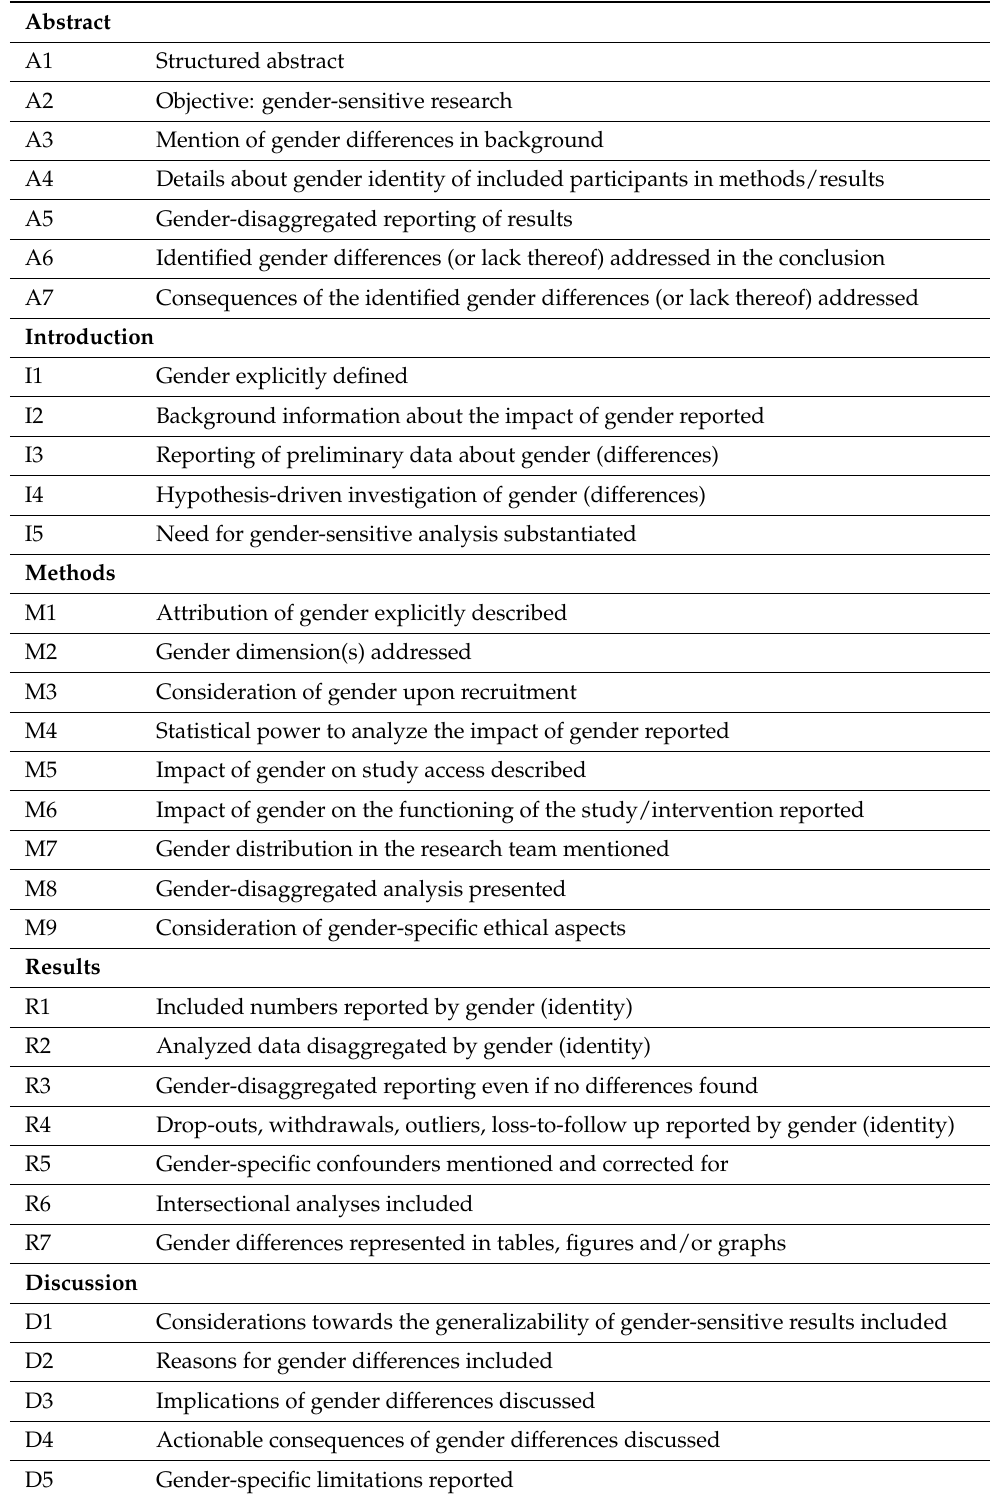
Table 1. Dimensions investigated in the different sections of the